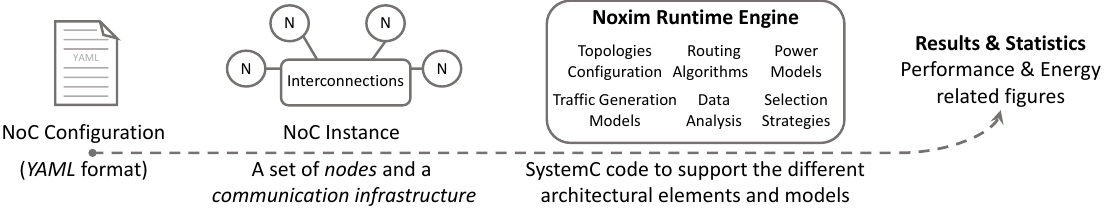
Figure 4. Cycle-accurate Noxim-based design flow. Table 1. Simulation parameter